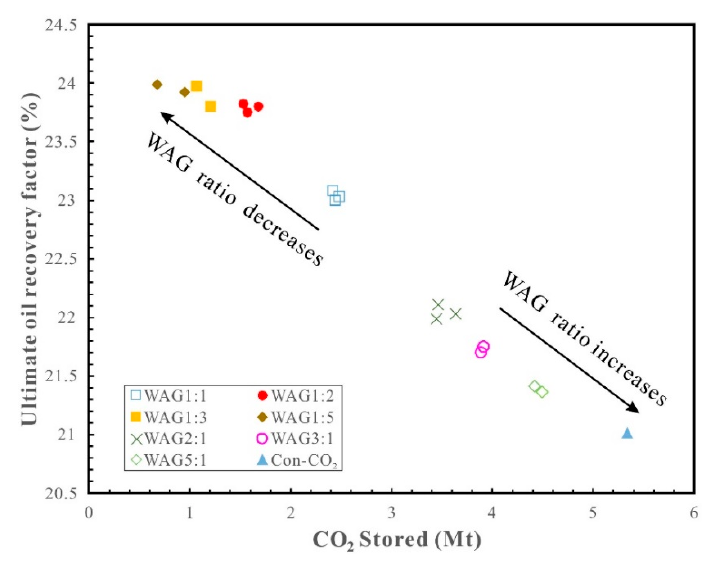
Figure 15. Correlation curves of results of the ultimate oil recovery factor and CO 2 stored in the CO 2 flooding scenarios with different CO 2 -water slug